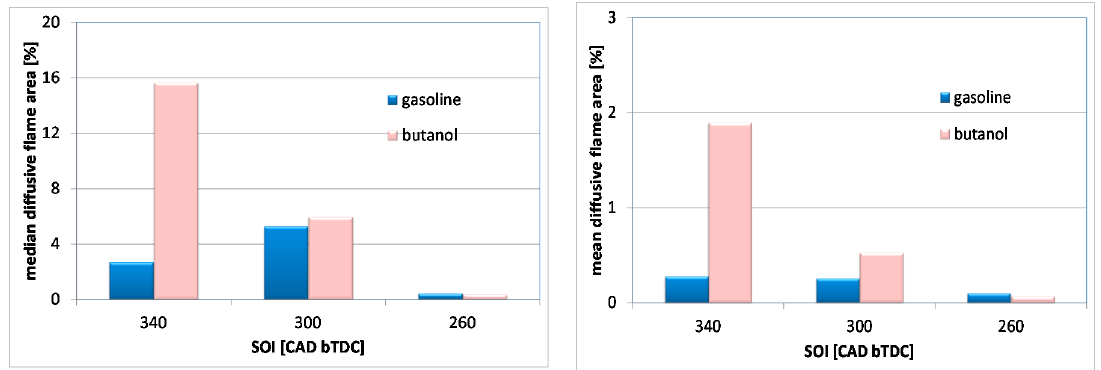
Figure 14. Diffusive flame area integrated over the working cycle.